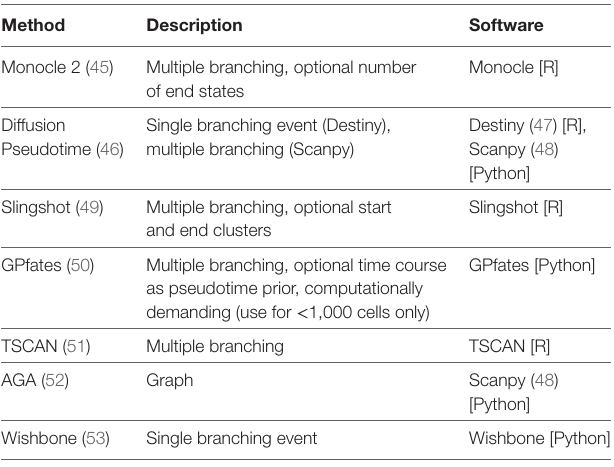
TABLe 1 | Overview of different trajectory inference